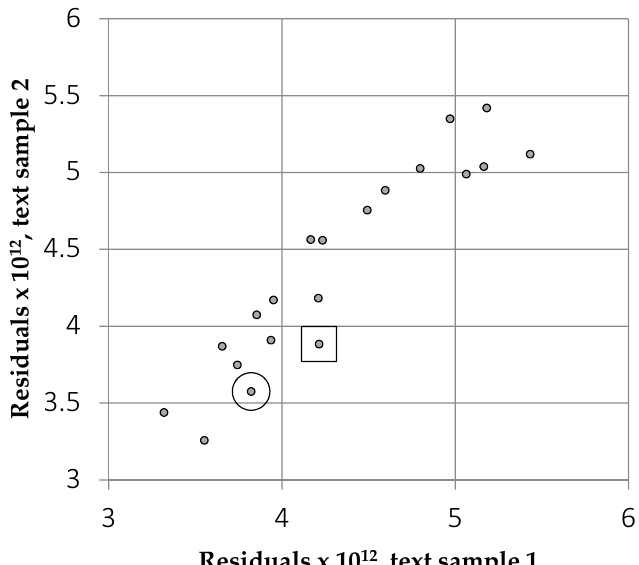
Figure 7. Residuals for the two samples of texts from Eliot and Trollope for each of the 20 fonts listed in Table 1. The lower the residuals, the more similar the text to images from nature. The points for Open Sans and Times are surrounded by a circle and a square respectively.